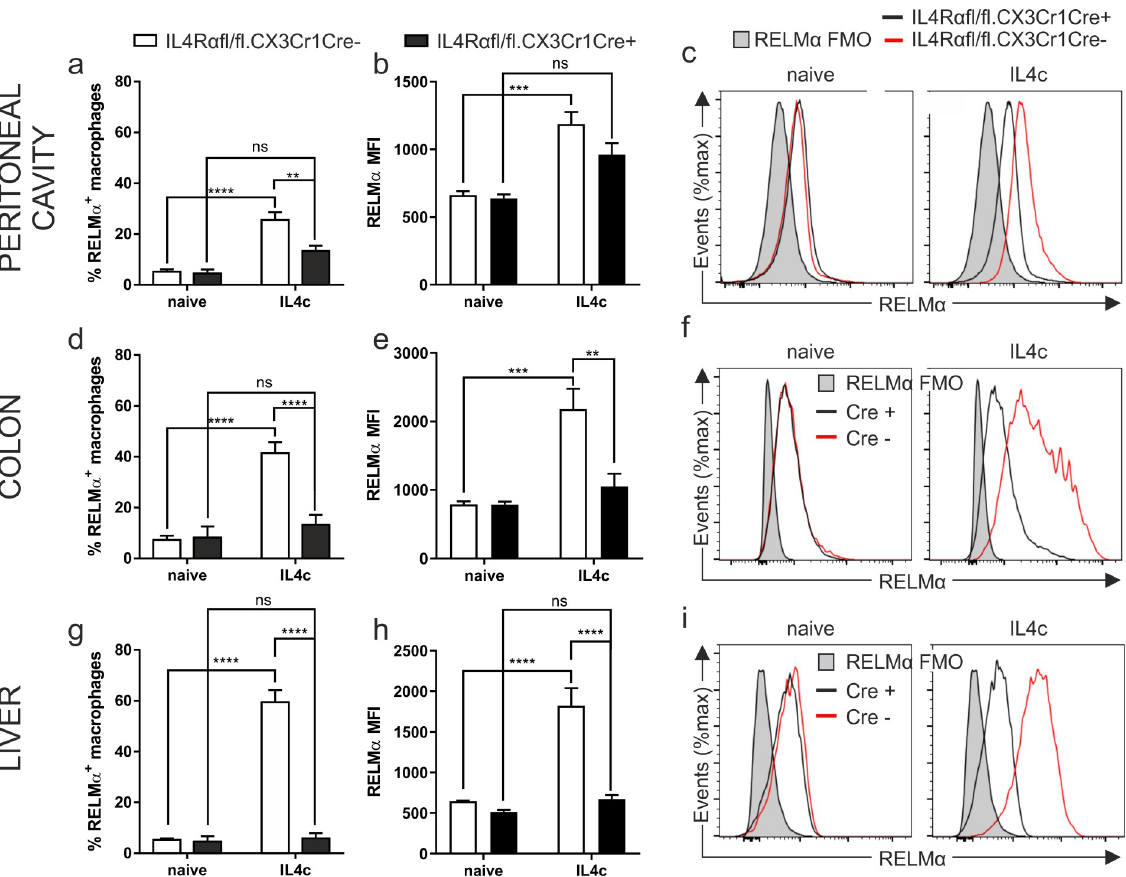
Fig 1. IL4R α fl/fl.CX3CR1Cre + macrophages are unresponsive to IL4 signalling. IL4R α fl/fl.CX3CR1Cre+ or IL4R α fl/fl.CX3CR1Cre- mice were injected intraperitoneally with recombinant IL4 complex and expression of RELM α analysed in the (a,b) peritoneal cavity, (d,e) colon and (g) liver 48hours later. Representative histograms show RELM α expression in the IL4R α fl/fl.CX3CR1Cre- (red) or IL4R α fl/fl.CX3CR1Cre+ (black) mice in the (c) peritoneal cavity, (f) colon and (i) liver compared to the FMO control. Data are combined from two independent experiments (na ï ve;n = 3–7, IL4c; n = 6). Error bars show means ± SEM. Statistical comparisons were performed with a two-way ANOVA with post-hoc Bonferroni’s multiple comparison test where appropriate: � p < 0.05, �� p < 0.01, ��� p < 0.001, ���� p < 0.0001 indicates significance as